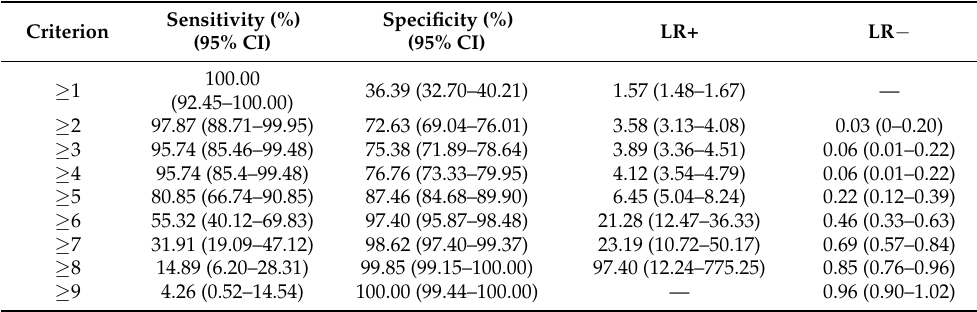
Table 4. Criterion values and the associated sensitivity, specificity, positive likelihood ratio (LR+), and negative likelihood ratio (LR − ) from the ROC curve